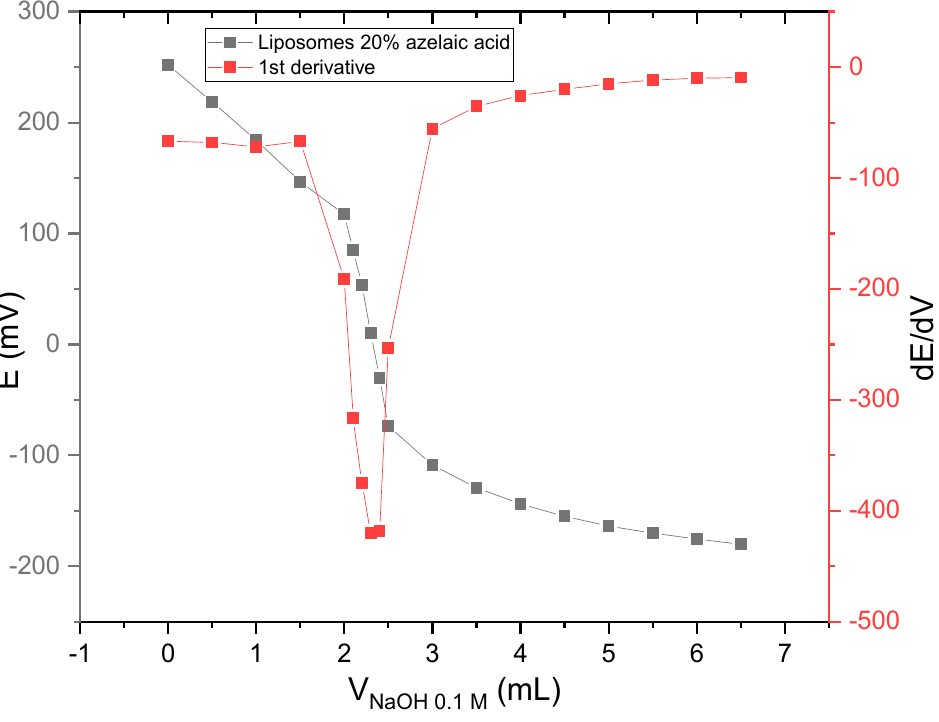
Figure 4. Potentiometric titration with NaOH of azelaic acid and the corresponding first deriva- tive.